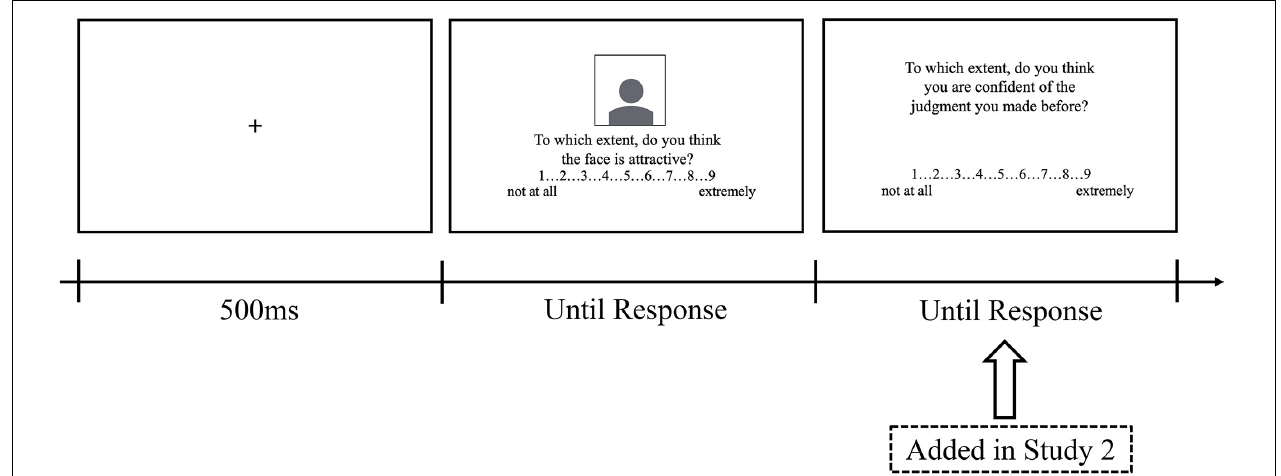
FIGURE 1 | The order of events in a typical trial of Studies 1 and